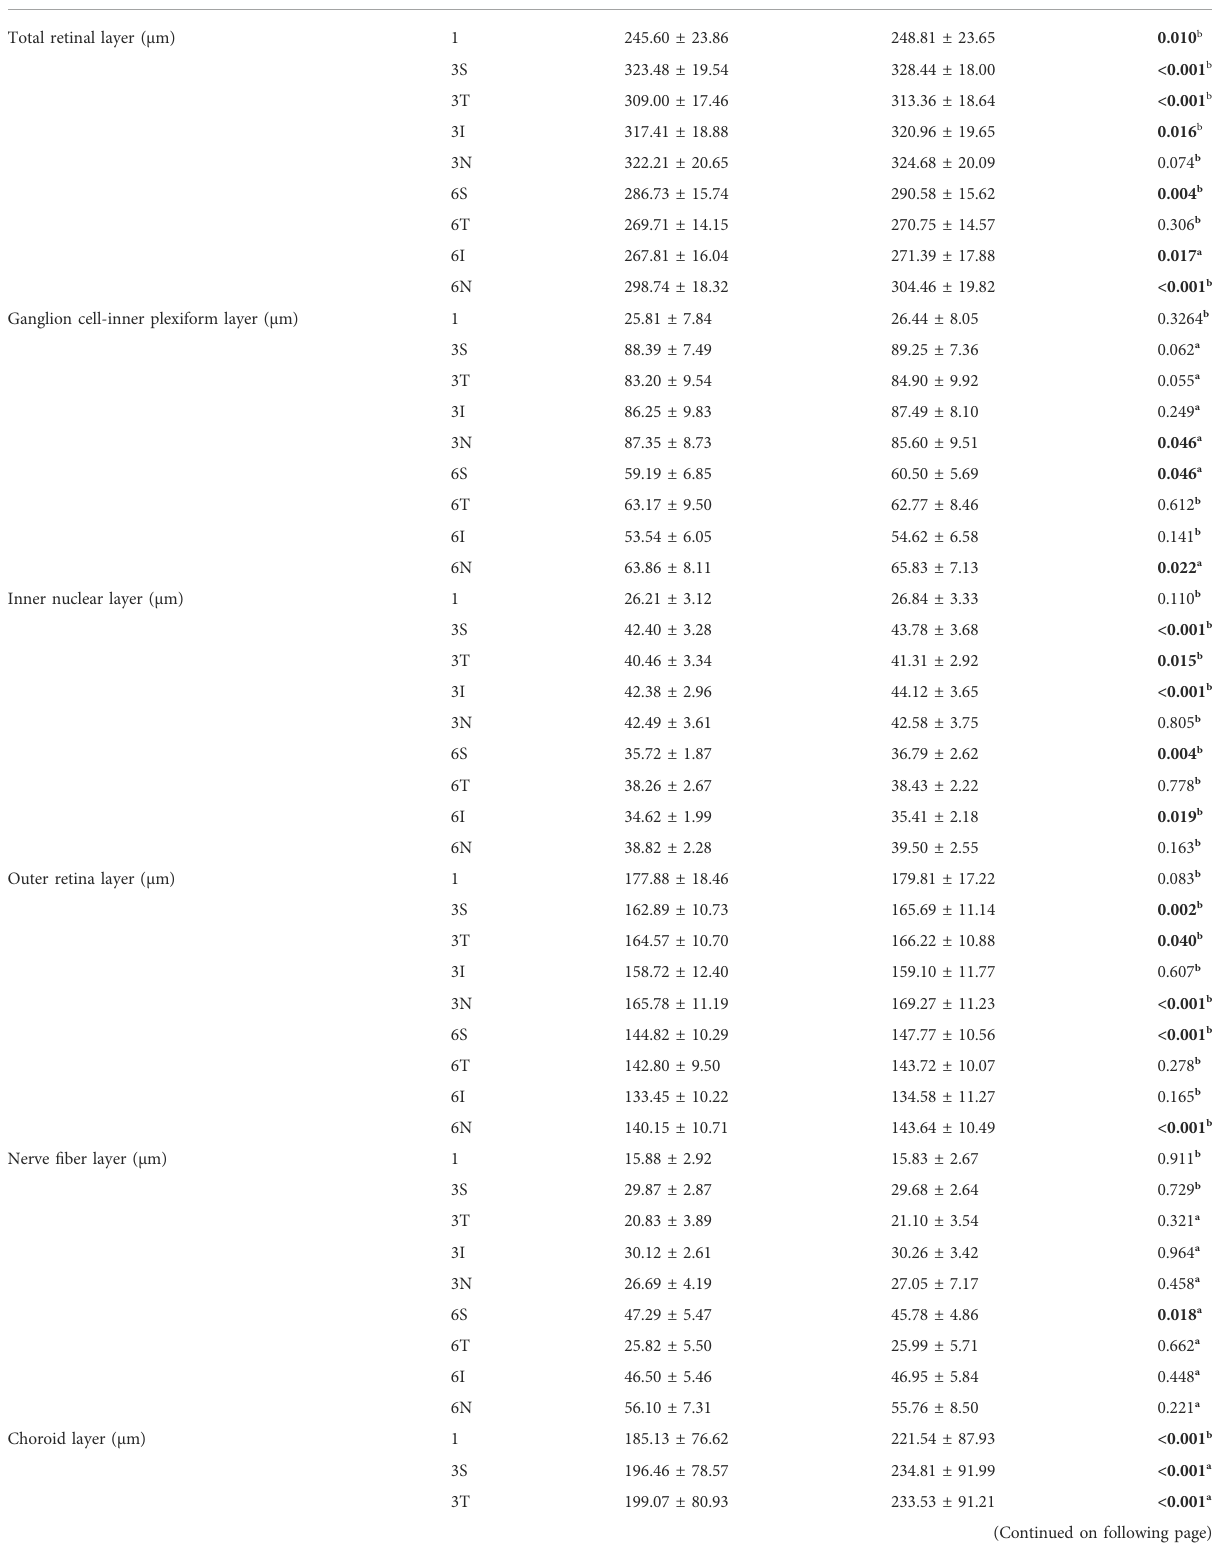
TABLE 2 Comparison of the regional thickness of each retinal layer and choroidal layer of more myopic and contralateral eyes. MM Contralateral P